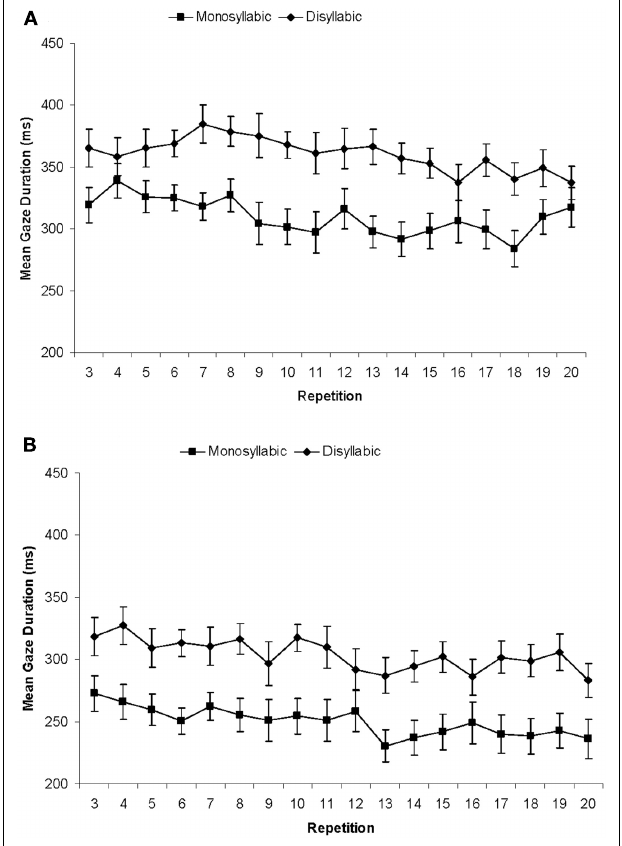
FIGURE 8 | Results of Experiment 2. Mean gaze durations (ms) for monosyllabic and disyllabic items on repetitions 3 through 20 in the Moderate Pace Group (A) and the Fast Pace Group (B)